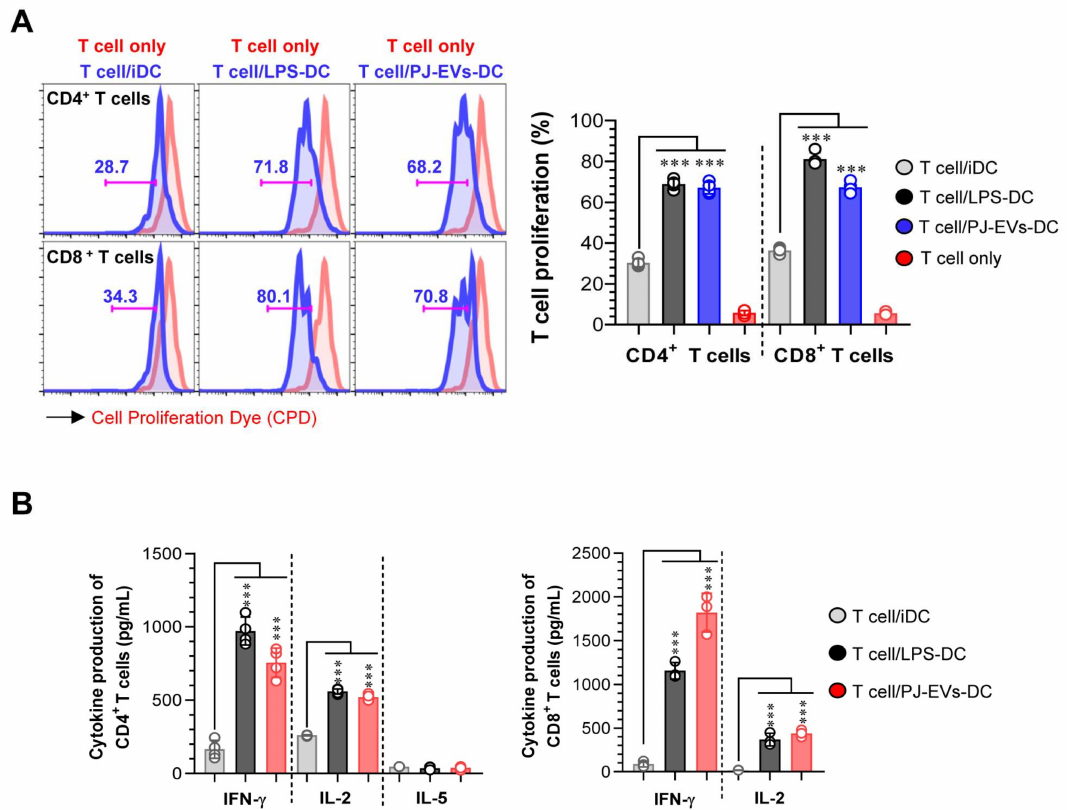
Figure 5. DCs treated with PJ-EVs initiate T cell proliferation and Th1 response. ( A ) PJ-EVs (30 µ g/mL)-treated DCs were cocultured with CPD-stained BALB/c background CD4 + and CD8 + T cells at a ratio of 0.2:1 (DCs and T cells, respectively). After 2 days of coculture, the proliferation of CD4 + or CD8 + T cells was analyzed by FACS. ( B ) Levels of indicated cytokines in the culture supernatant were analyzed using ELISA. The results are indicated as mean ± SD (n = 4 samples) of three representative experiments. *** p < 0.001. SD: standard